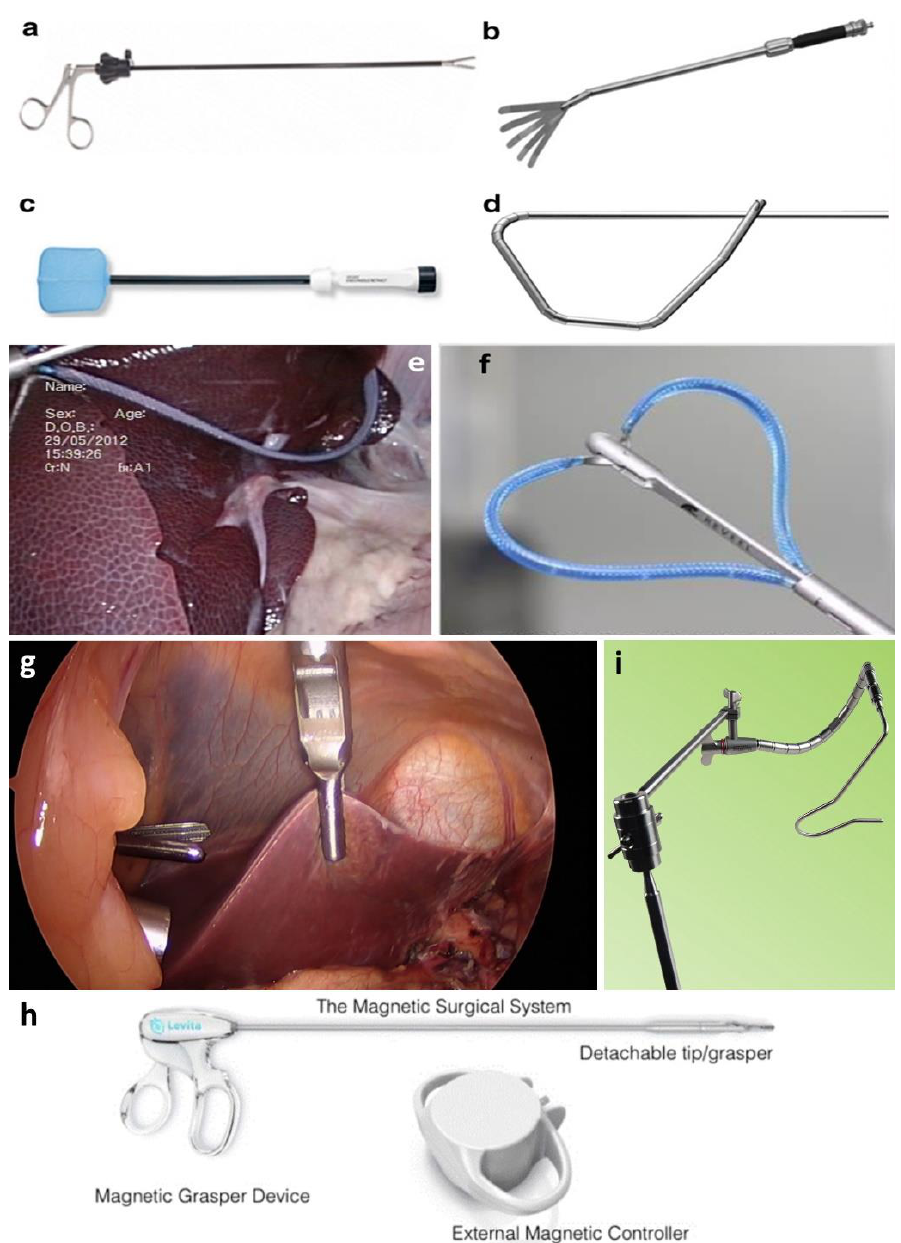
Figure 2. Retractors used in MIS. ( a ) Laparoscopic bowel graspers (Medline Industries, Northfield, IL, USA). ( b ) Laparoscopic fan retractor (LocaMed Ltd., London, UK). ( c ) Inflatable Endo-paddle retractor (Covidien Surgical, Dublin, IE). ( d ) Snowden – Pencer triangular liver retractor (Cardinal Health, Dublin, OH, USA). ( e ) Kelly liver retractor in deployment (Surtex Instruments, London, UK). ( f ) Inflatable design from the Chinese University Hong Kong. ( g , h ) Levita Magnetic Surgical System with detachable head. ( i ) Nathanson liver retractor systems (Mediflex Surgical Products) [12].